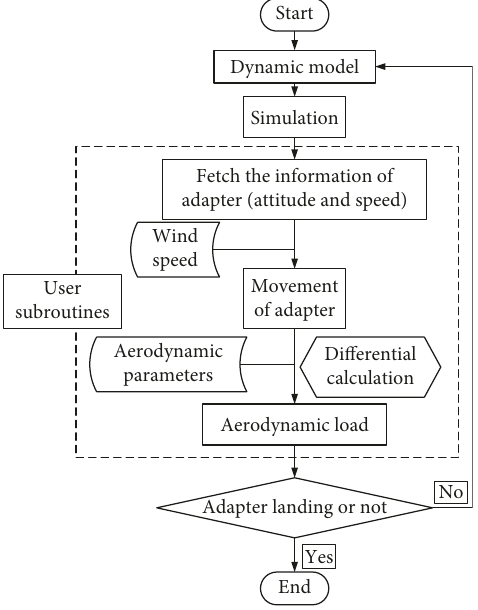
Figure 5: The simulation fl